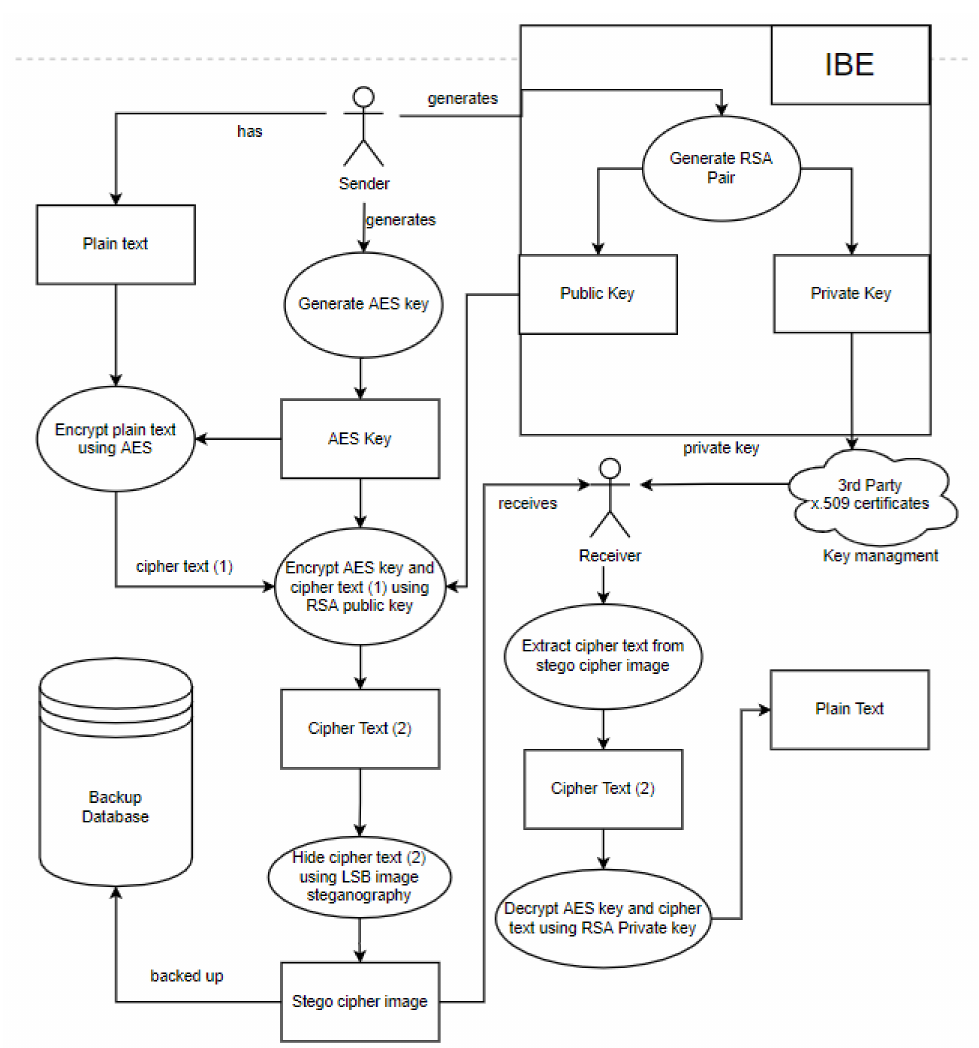
Figure 4. A description of the four steps of the security